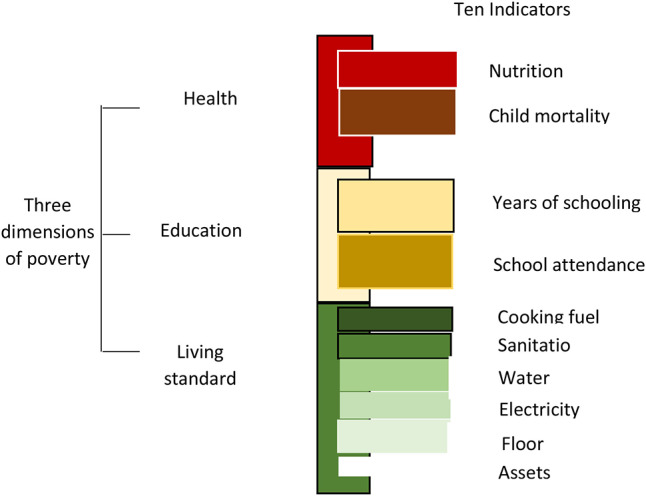
Dimensions of MPI. Source: Alkire and Santos (13).